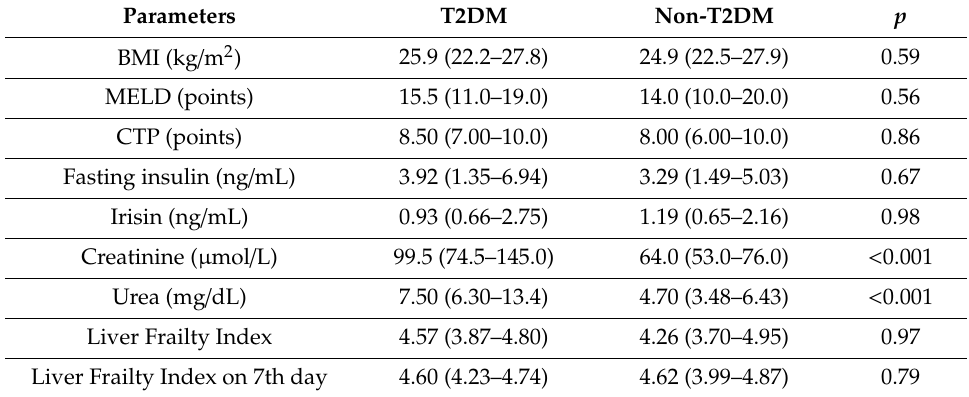
Table 10. Comparison of analyzed parameters between diabetic and non-diabetic